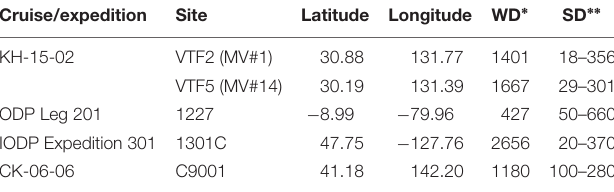
TABLE 1 | Sampling